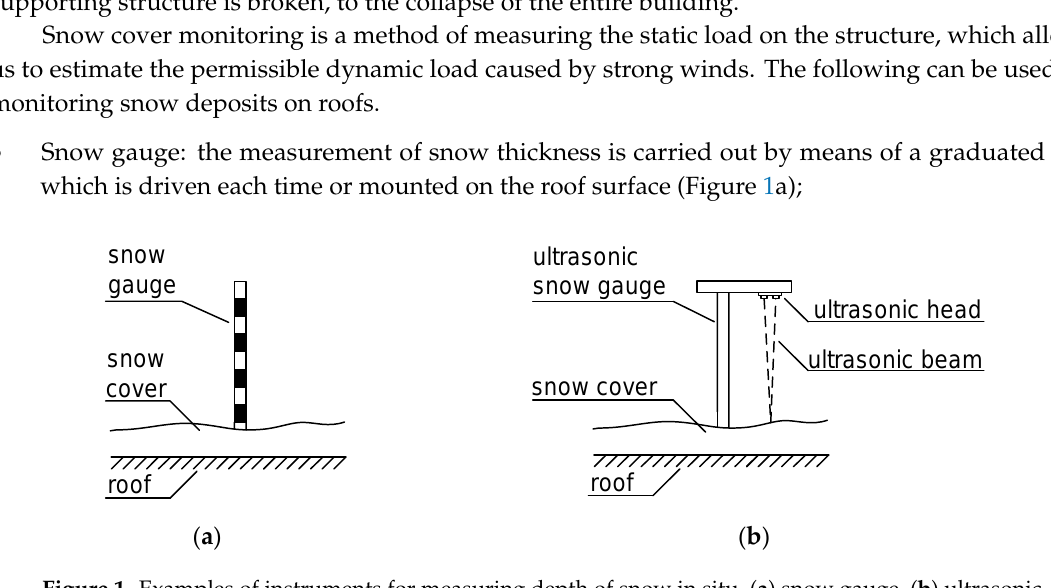
Figure 1. Examples of instruments for measuring depth of snow in situ, ( a ) snow gauge, ( b ) ultrasonic snow depth sensor.